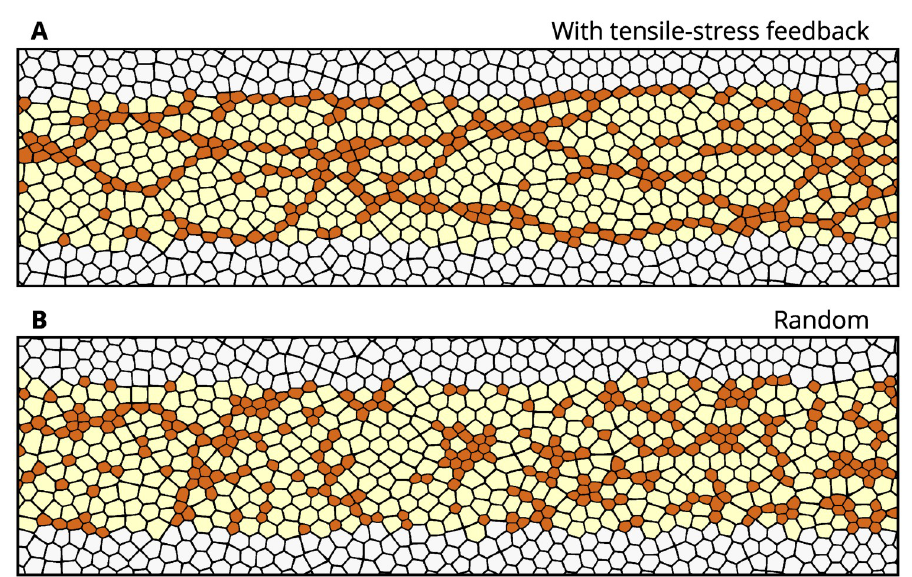
Fig 5. Model showing the effect of tensile-stress feedback on the cellular constriction pattern. Predictions of the AGF model for the multicellular patterns formed by constricted cells ( A ) in a system with tensile feedback ( β = 250) and ( B ) in a stress insensitive random system ( β = 0); in both cases 40% of cells in the active region have constricted. The tensile feedback present in (A) results in formation of chains of constricted particles, similar to cellular constriction chains observed during the initial phase of